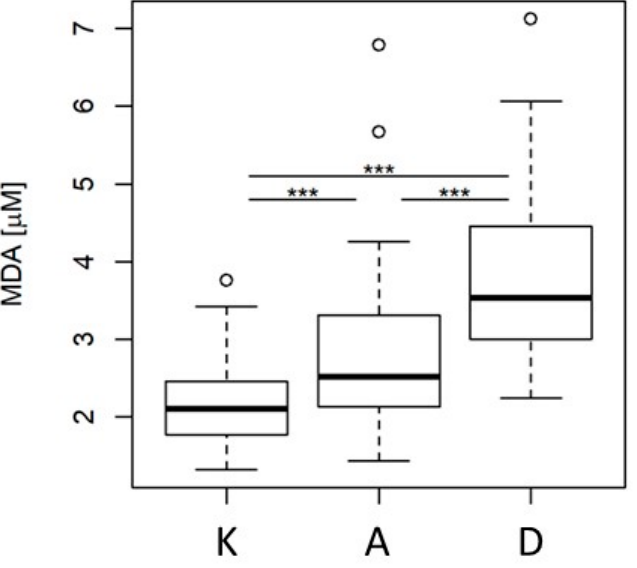
Figure 6. Box plot of MDA levels in patients’ plasma: A—acute coronary syndrome; D—acute ischemic stroke, K—control group. A vertical boxplot is constructed between the first (Q1) and third (Q3) quartile, with the horizontal median inside. Data displayed as circles are outliers. *** p < 0.001 using post hoc Dunn’s test.